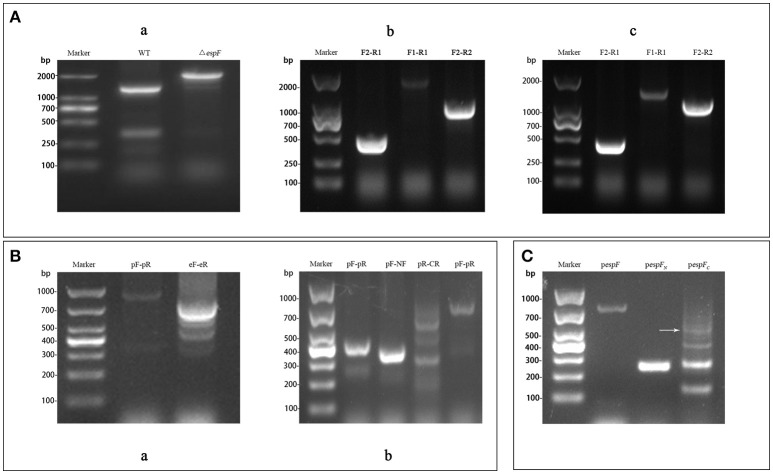
Construction of the EHEC O157:H7 mutant and complementation strains. (A) Electrophoresis verification of the mutant strains. (a) WT: Amplification of wild-type using primers F1-R2 (1,289 bp); ΔespF: Amplification of ΔespF using primers F1-R2 (2,019 bp); (b) F2-R1: Amplification of ΔespFN using primers F2-R1 (471 bp); F1-R1: Amplification of ΔespFN using primers F1-R1 (2,015 bp); F2-R2: Amplification of ΔespFN using primers F2-R2 (1,002 bp); (c) F2-R1: Amplification of ΔespFC using primers F2-R1 (471 bp); F1-R1: Amplification of ΔespFC using primers F1-R1 (1,487 bp); F2-R2: Amplification of ΔespFC using primers F2-R2 (1,221 bp). (B) Identification of complementation strains by cross PCR. (a) pF-pR: Amplification of pespF using primer pF and pR (948 bp); eF-eR: Amplification of pespF using primers eF and eR (779 bp); (b) pF-pR: Amplification of pespFN using primers pF and pR (423 bp); pF-NF: Amplification of pespFN using primer pF and NF (373 bp); pR-CR: Amplification of pespFC using primers pR and CR (607 bp, white arrow); pF-pR: Amplification of pespFC using primers pF and pR (732 bp). (C) Agarose gel electrophoresis of the RT-PCR products. pespF: RT-PCR results of pespF (779 bp); pespFN: RT- PCR results of pespFN (252 bp); pespFC: RT-PCR results of pespFC (557 bp, arrow).